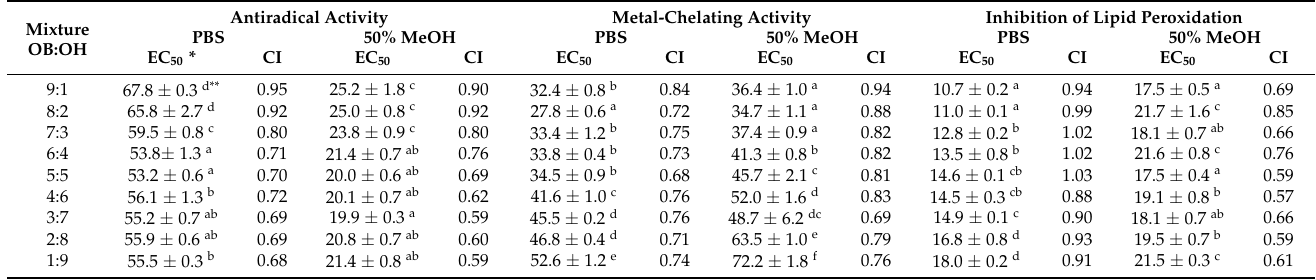
Table 3. Antioxidant Activity of OB and OH Mixtures and Combination Index.